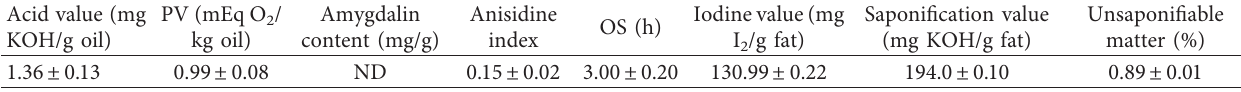
Table 1: Quality parameters of sour cherry kernel